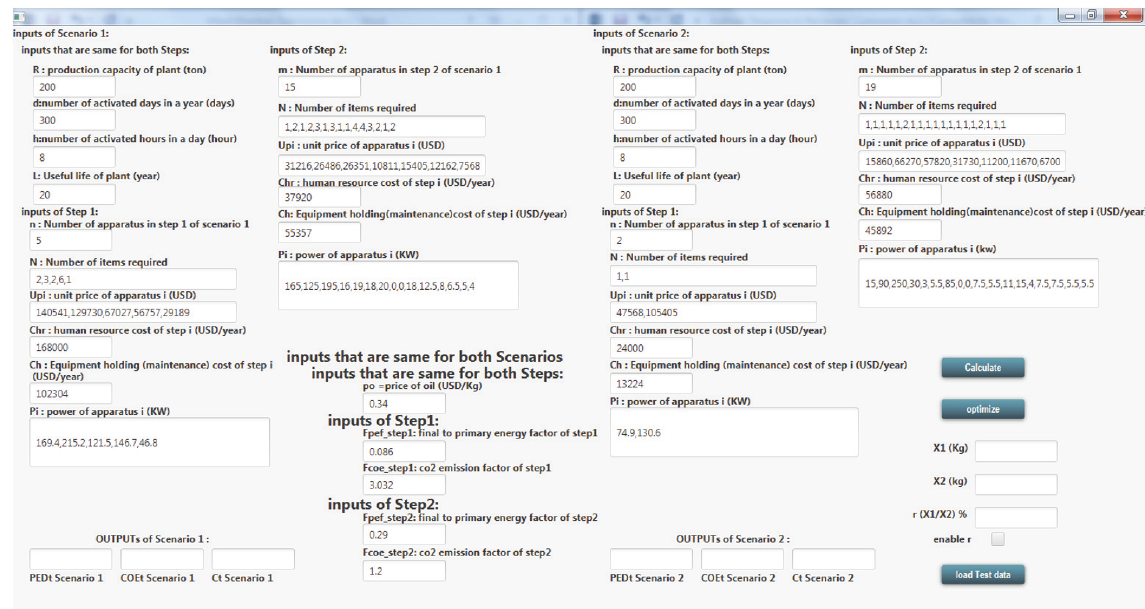
Figure 3: Software program created for analysis of the model via Java programming language.